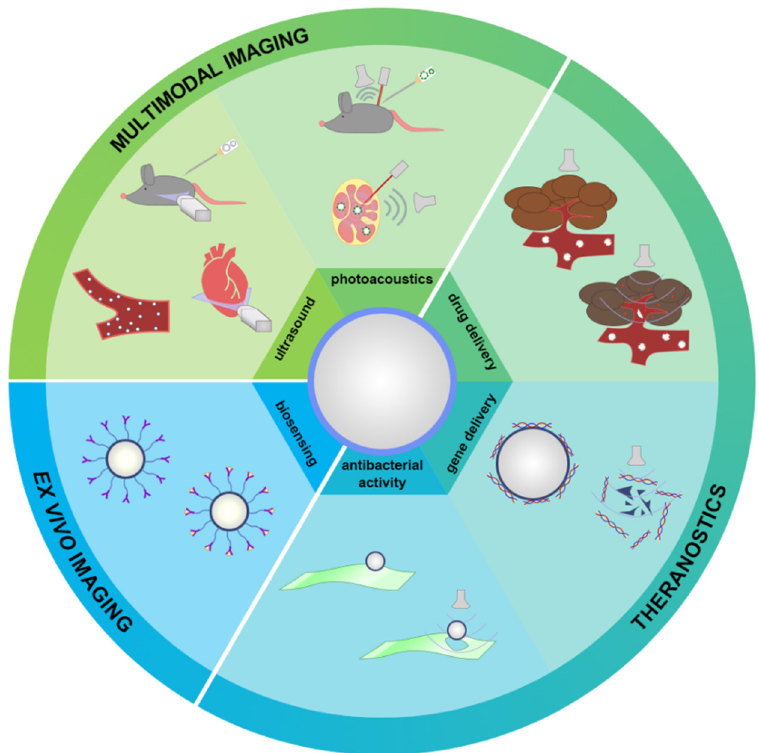
Figure 6. Applications of MBs with protein shell. Historically, protein MBs were the first contrast agent for cardiac US imaging, while recent advances in photoacoustic imaging expanded their multi- modal imaging applications. Theranostic strategies result in US-assisted drug and gene delivery and antibacterial purposes based on US-assisted MB destruction. Ex vivo imaging purposes demonstrated with MB-assisted biosensing can widen the range of MB applications.